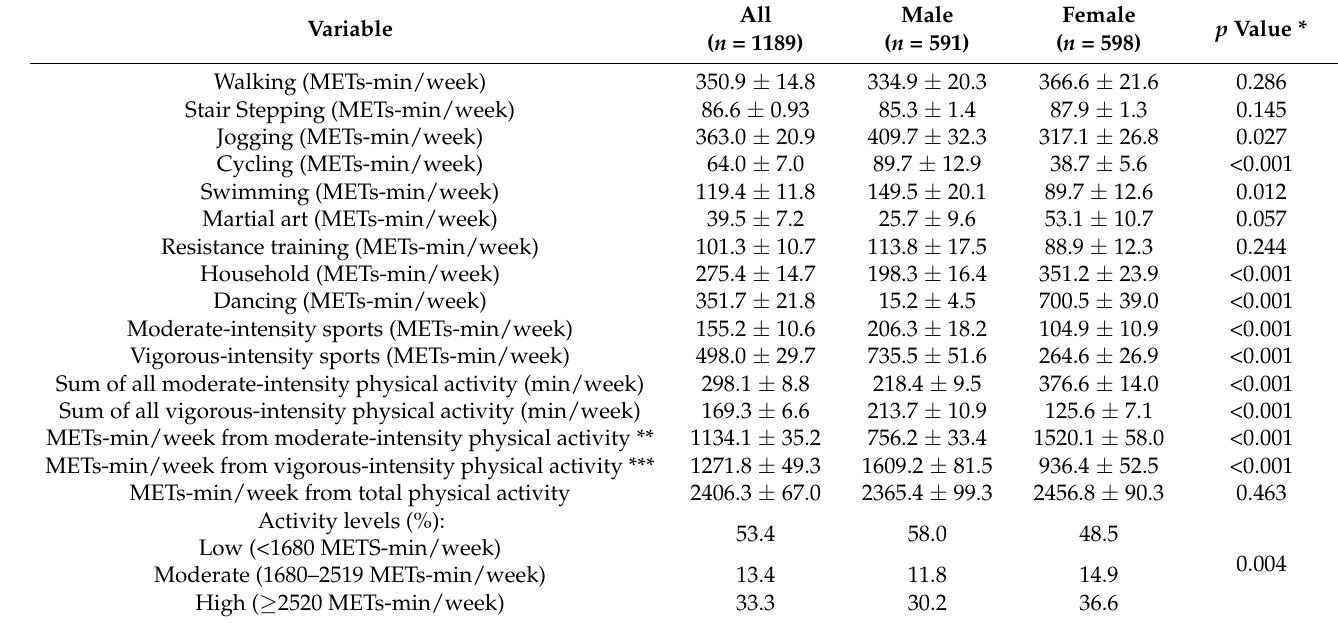
Table 3. Activity energy expenditure (METs-minutes/week) expended in different types of physical activity by Saudi